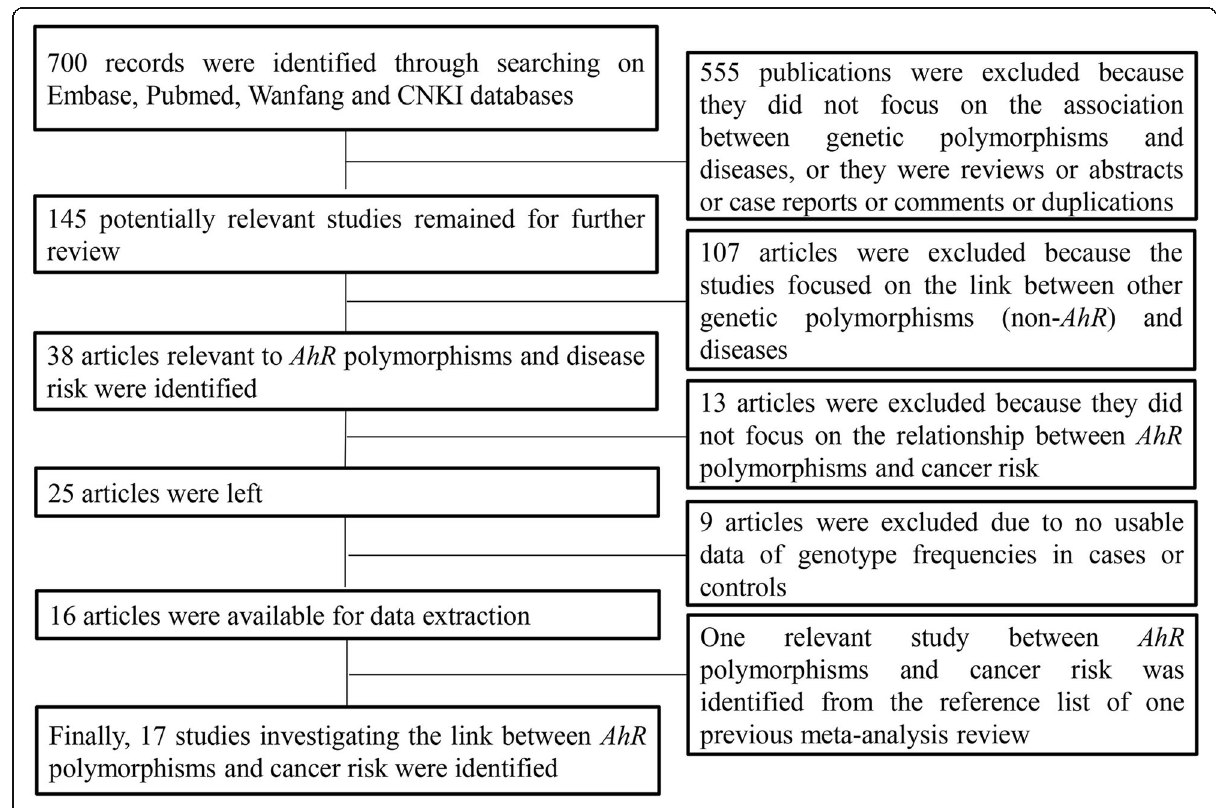
Fig. 1 Flow chart depicting the process of identifying eligible studies